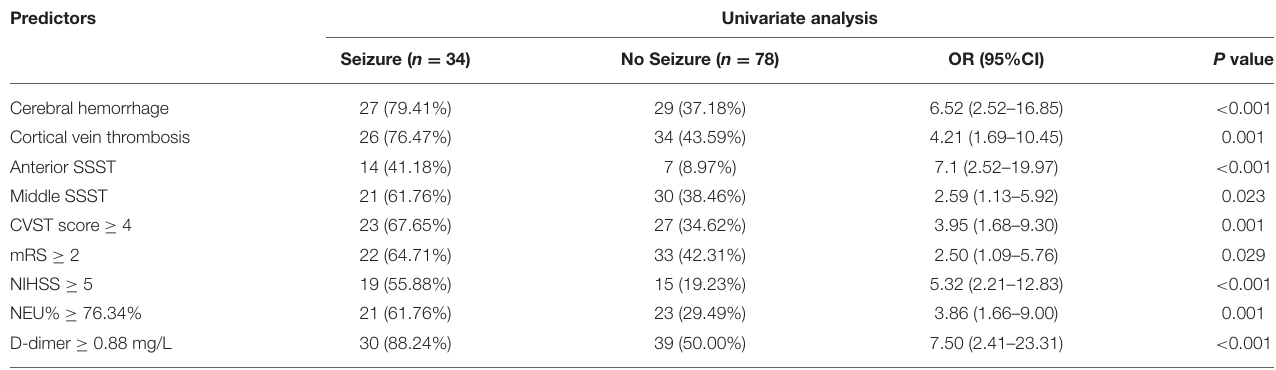
TABLE 2 | Univariate analysis of risks of early-onset seizures.